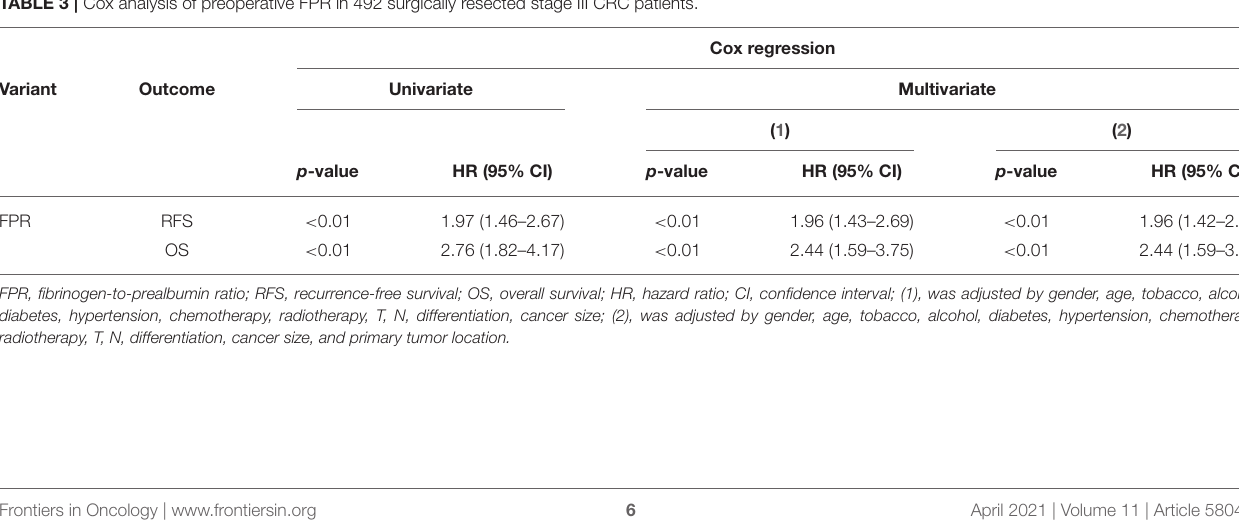
TABLE 3 | Cox analysis of preoperative FPR in 492 surgically resected stage III CRC patients.